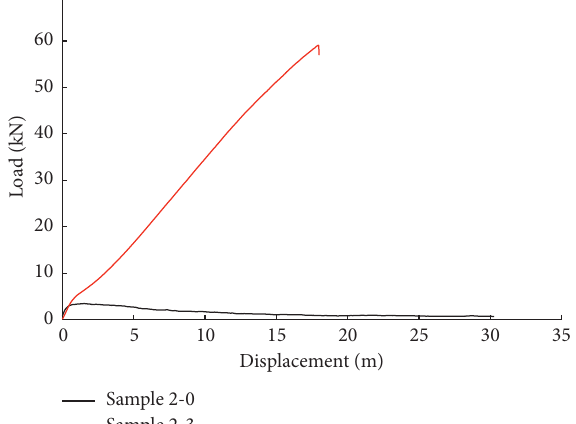
Figure 9: Load-displacement curves of samples 2-0 and 2-3.